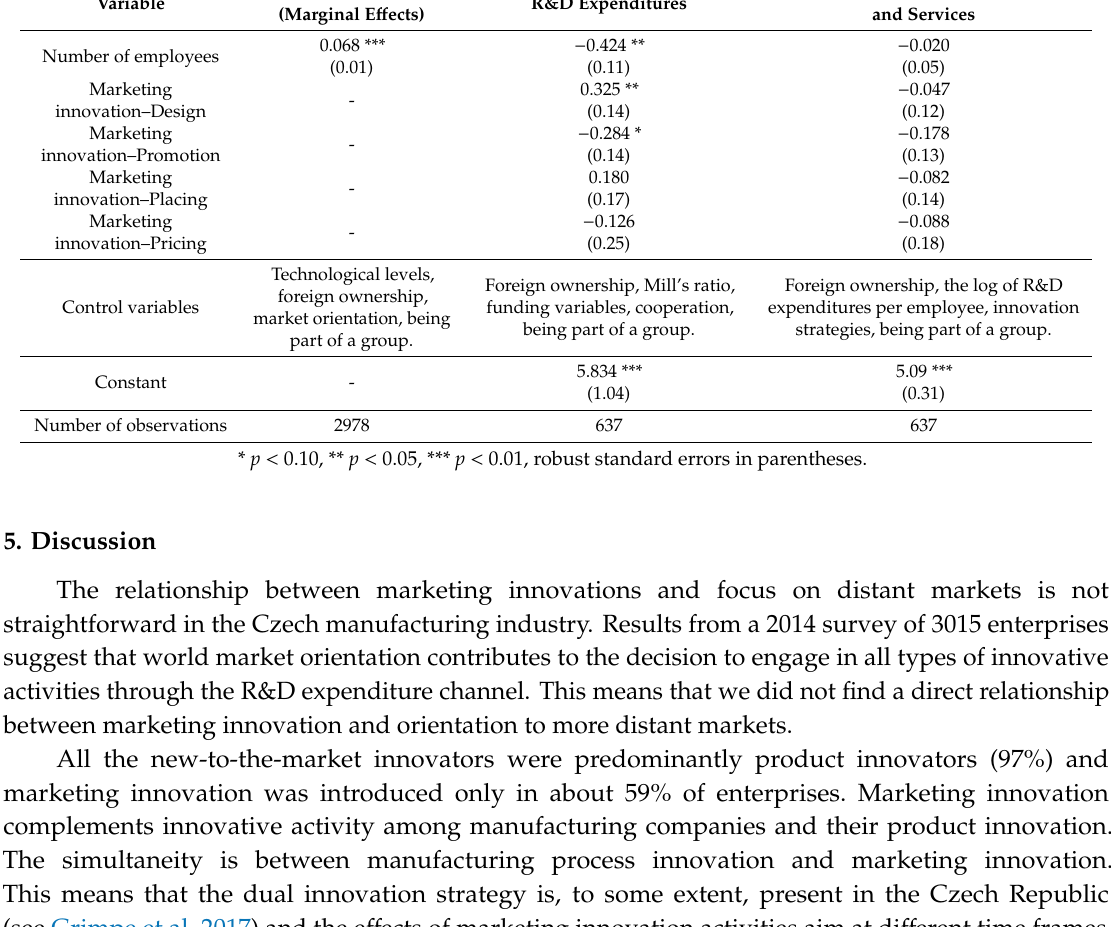
Table 5. The decision to innovate, R&D expenditures and sales of innovated goods intensity.